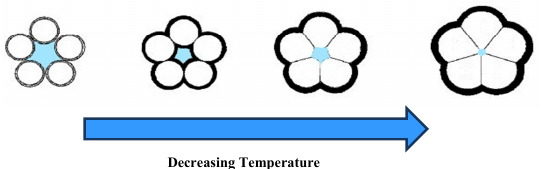
Figure 1: Effect of decreasing the size of “micropockets” in solution as a function of Fig. 5. Schematic representation of how the amount of liquid rep- temperature. 4 resented by the blue area adjusts to temperature and how it may be trapped in veins forming micro-inclusions (O’Concubhair and Sodeau, 2013). Reprinted with permission from Takenaka et al. (1996). Copyright (1996) by the American Chemical